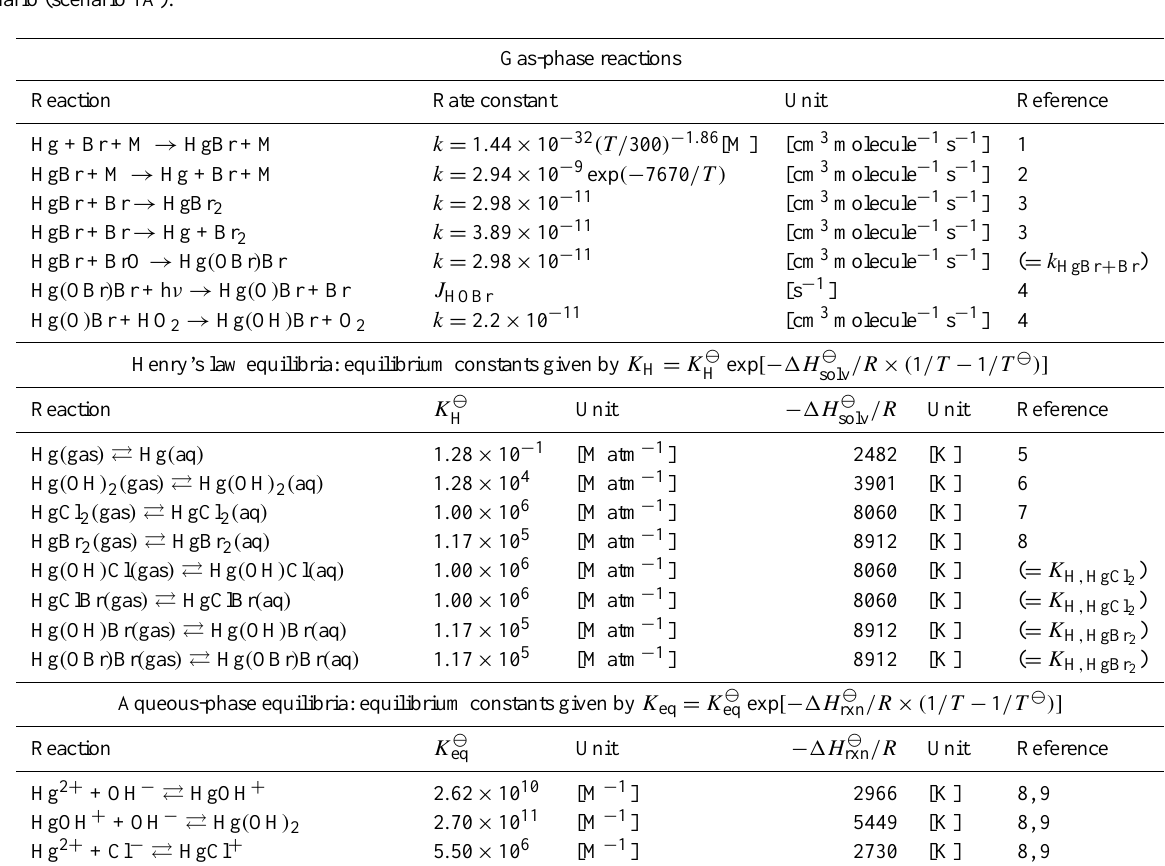
Table 1. List of reactions and multiphase mass transfers for mercury species and the rate and equilibrium constants used in our baseline scenario (scenario